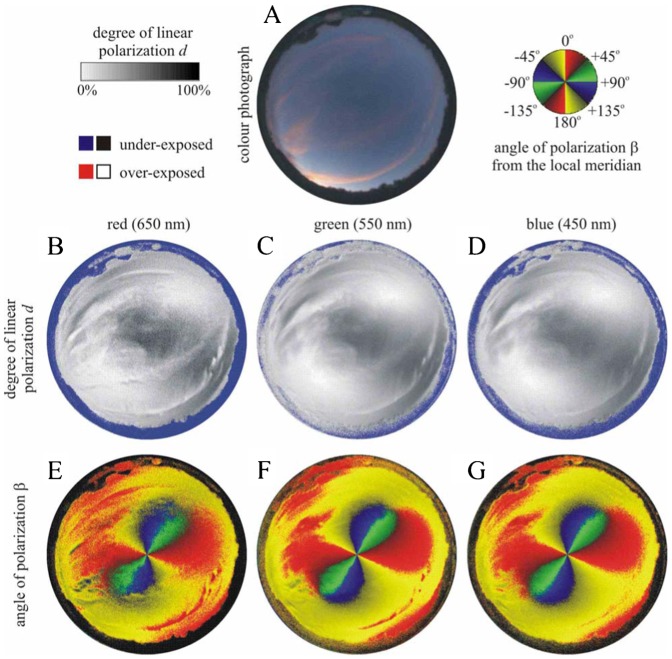
As Fig. 4 for the sky no. 584 with cirrus clouds